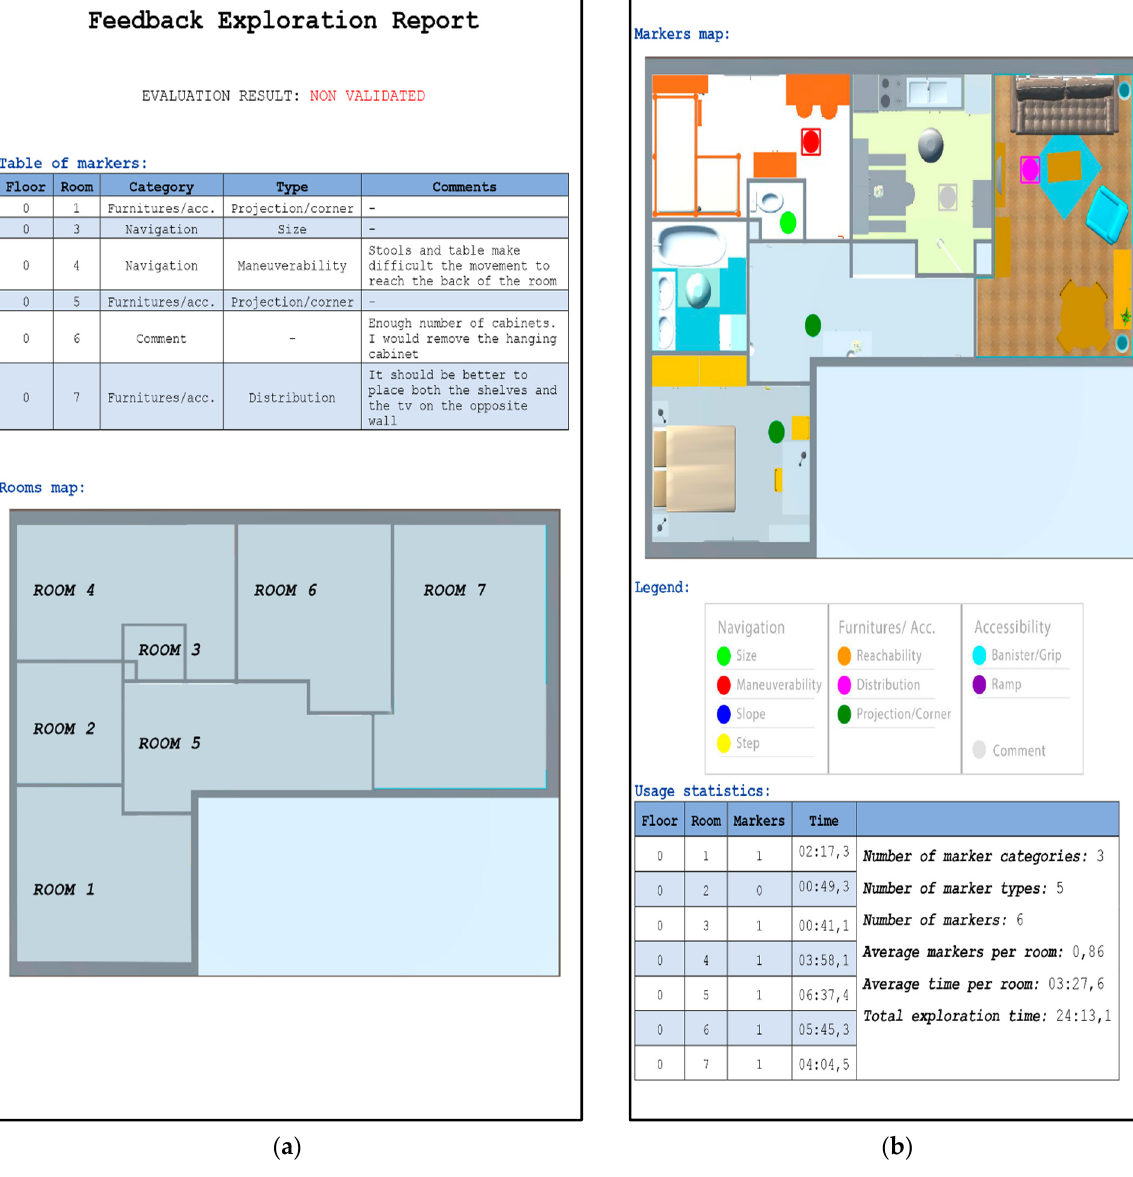
Figure 10. Example of a two-page feedback report generated after the user explored the design shown in Figure 2 and inserted some markers and commentaries: ( a ) first page with the list of inserted markers, their commentaries and the map of rooms; ( b ) second page with distribution of markers on the map, the legend of this map and some statistics on the number and type of markers and, the times.